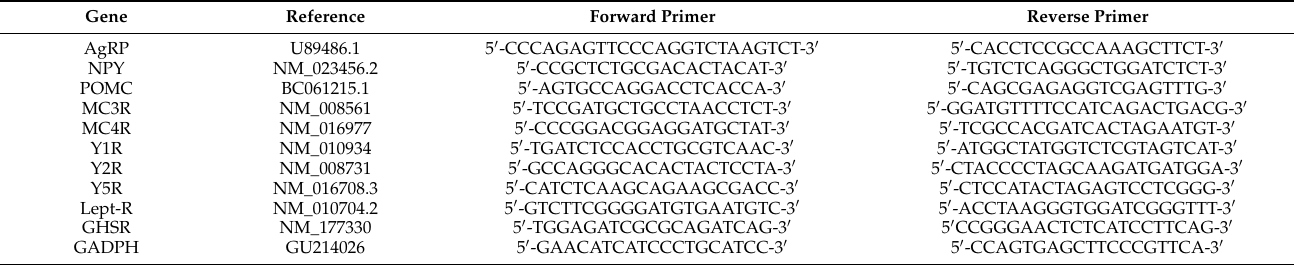
Table 1. List of PCR primers. AgRP, agouti-related peptide; GAPDH, glyceraldehyde-3-phosphate dehydrogenase; GHSR, ghrelin receptor, Lept-R, leptin receptor; MC3-R/MC4-R, melanocortin 3 and 4 receptors; NPY, neuropeptide Y; POMC, proopiomelanocortin; Y1-R/Y5-R, neuropeptide Y receptor 1/receptor 5.